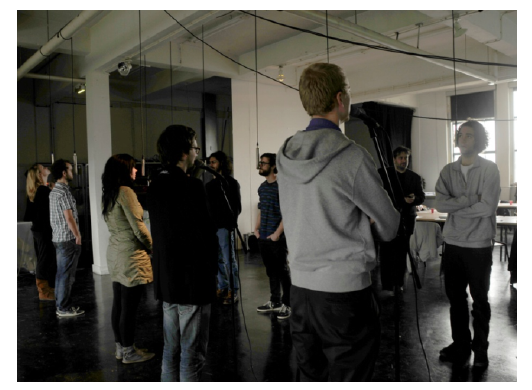
Fig. 9 . Ouija Drawing. Participants conducting an Ouija Drawing exercise, each with their own pen, connected to each other through the metal structure and elastic strings around their hands. The structure and the elastic strings let each movement be communicated to and affected by the movements of